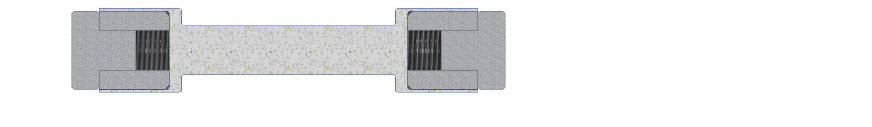
Figure 9. Cross section of the rotor, revealing the outer aluminium hull and the inner ferromag- netic